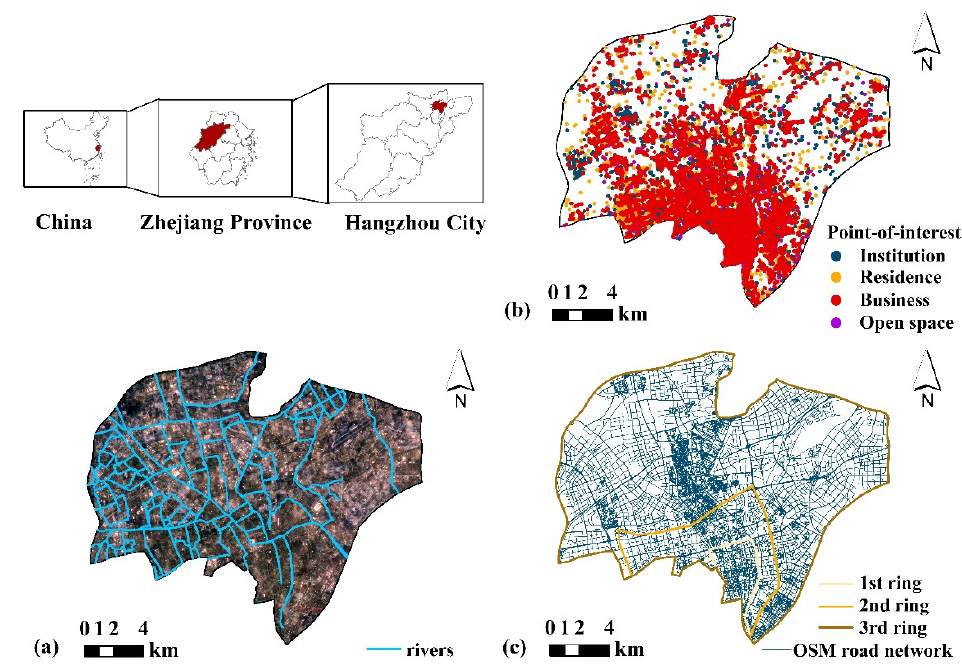
Figure 2. The study site ( a ) Sentinel-2 true-color composition image with OSM river network; ( b ) Spatial distribution of Point-of-interests (POI); ( c ) Road network extracted from OpenStreetMap (OSM).